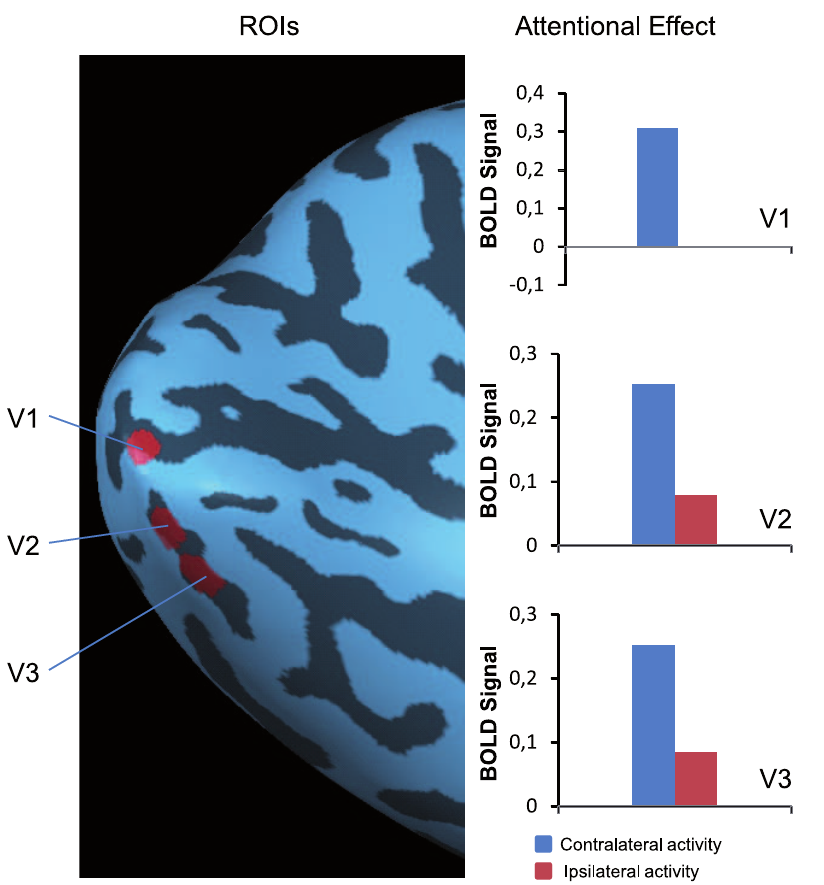
Figure 2. Example of mapped regions-of-interest (ROIs) and the attentional effect obtained at these ROIs. Example of ROIs mapped onto the inflated left hemisphere of a typical subject. Bar graphs represent the attentional effect (contra-lateral (blue) activity versus ipsilateral (red) activity) obtained at these ROIs. For each participant and each hemisphere ROIs were mapped in this manner and time courses were obtained at these individually mapped ROIs.